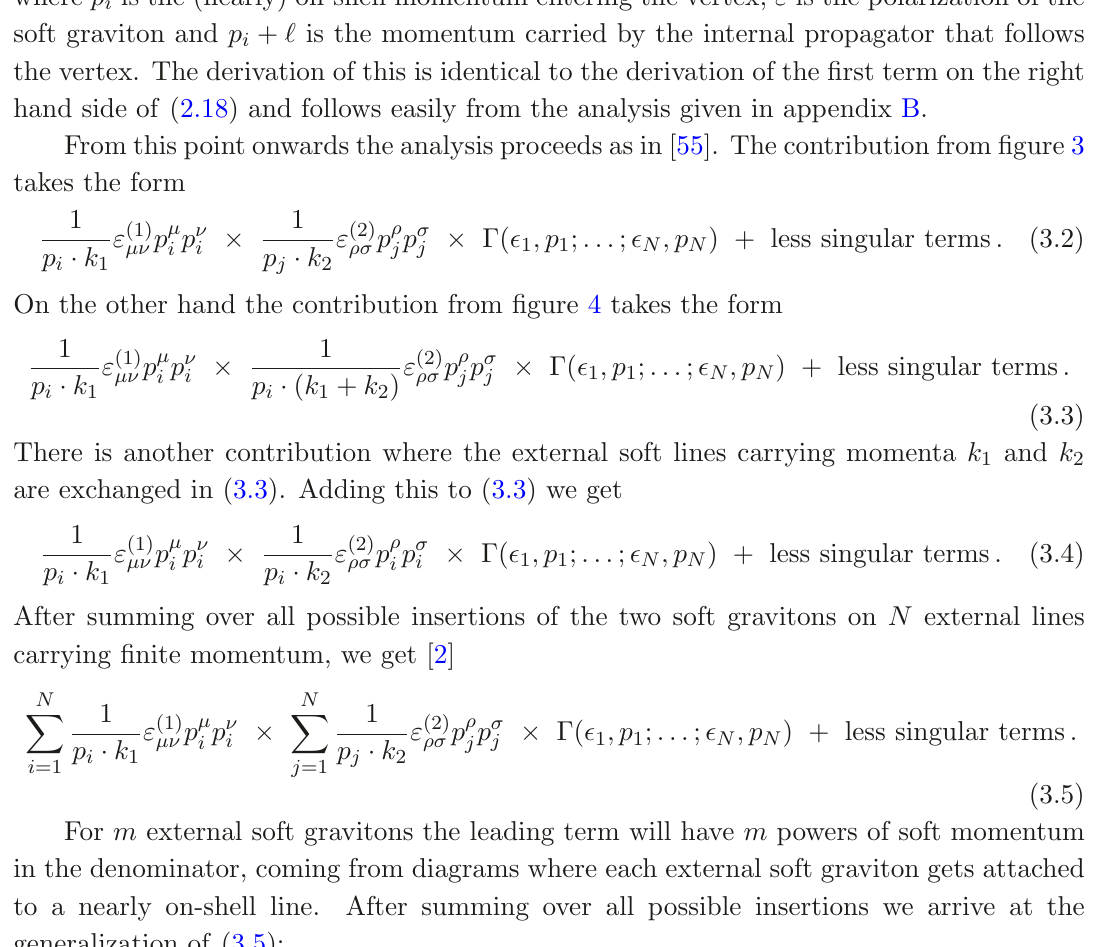
where p i is the (nearly) on-shell momentum entering the vertex, ε is the polarization of the soft graviton and p i + ℓ is the momentum carried by the internal propagator that follows the vertex. The derivation of this is identical to the derivation of the first term on the right hand side of (2.18) and follows easily from the analysis given in appendix